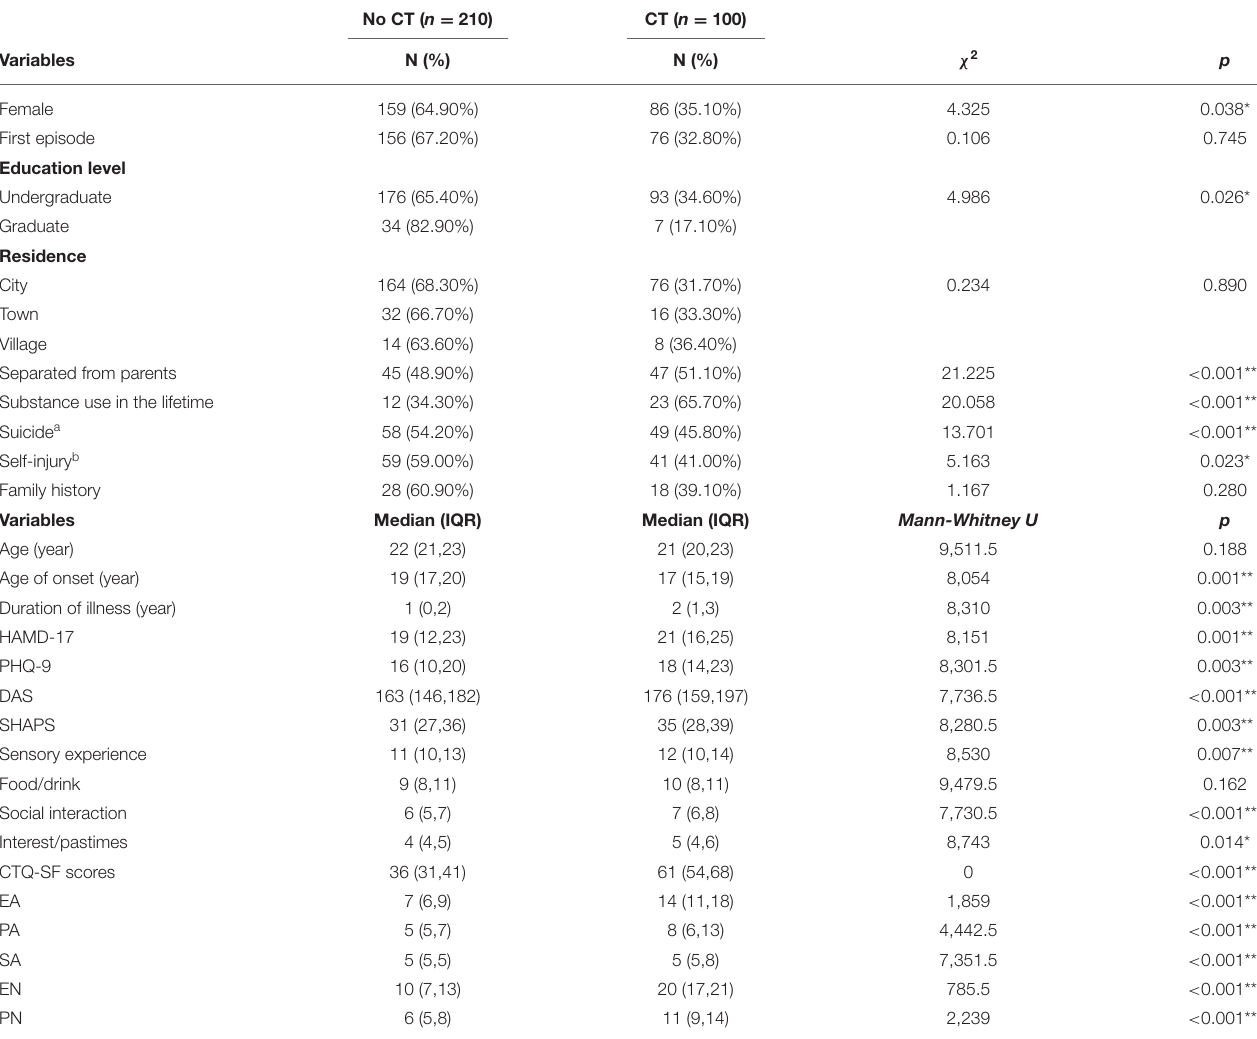
TABLE 1 | The socio-demographic and clinical characteristics.